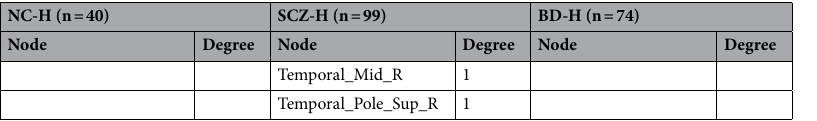
Table 2. Node degree of NBS network per group. NC-H non-clinical individuals with hallucinations, BD- H bipolar-I disorder with lifetime history of hallucinations, SCZ-H schizophrenia spectrum disorder with